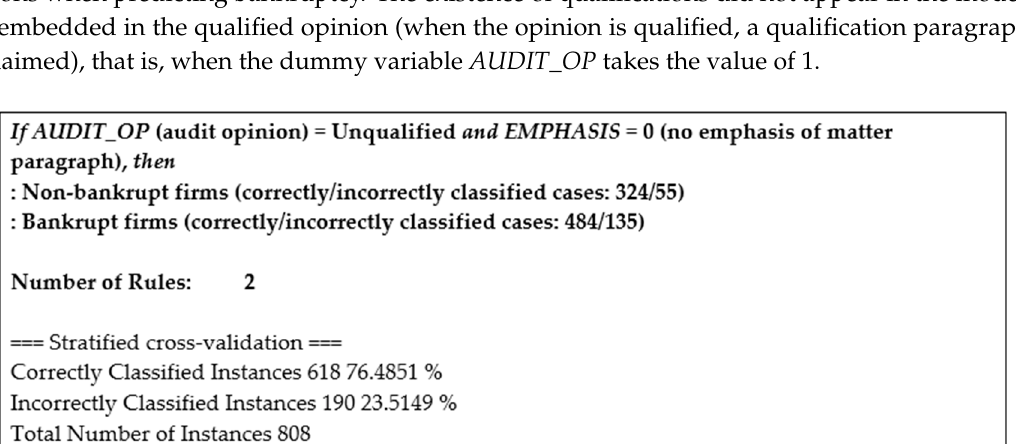
Figure 3. Model 3: The audit opinion, type of paragraphs, and number of comments in the PART model.